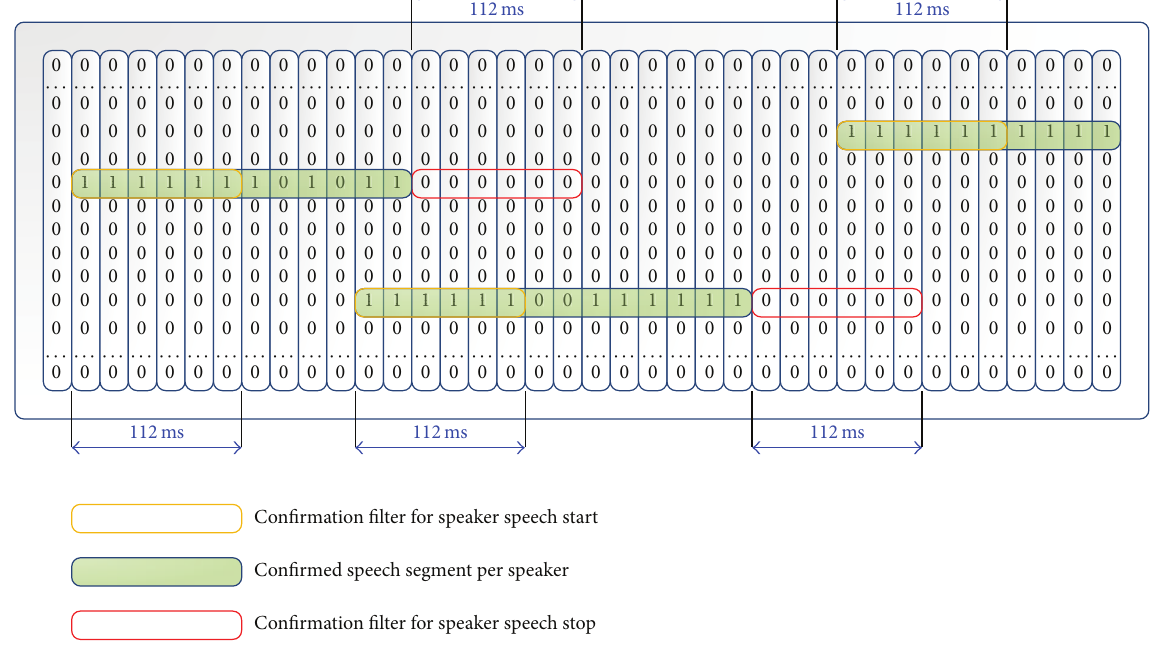
Figure 9: Spatiotemporal fingerprint processing. Each column of bits (zeros and ones) represents a spatial fingerprint, a union of several consequent columns represents a spatiotemporal fingerprint. Ones correspond to voice activity; zeros correspond to silence. Horizontal bit position defines instant in time. Vertical bit position defines azimuth with respect to microphone